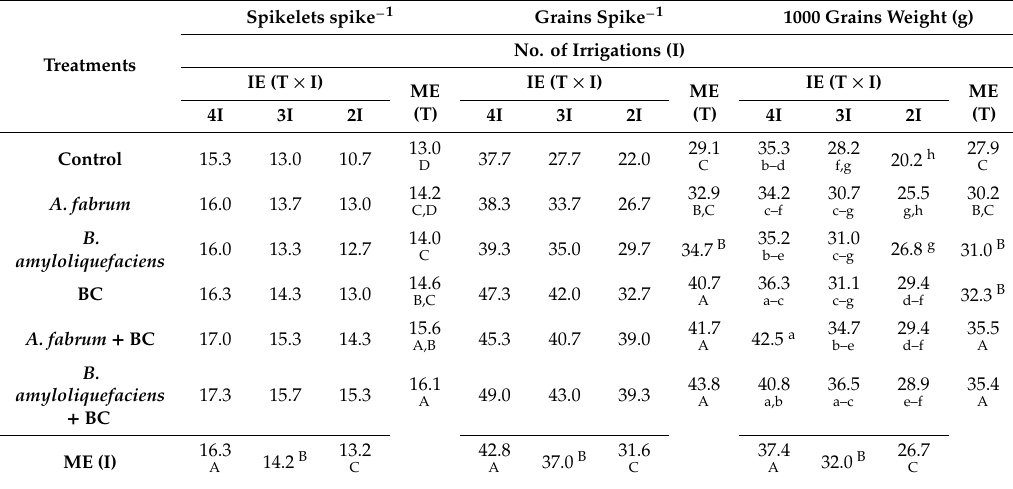
Table 3. E ff ect of Agrobacterium fabrum , Bacillus amyloliquefaciens with / without biochar (30 Mg ha − 1 ) on spikelet’s spike − 1 , grains spike − 1 and 1000 grains weight of wheat cultivated in drought-stressed field